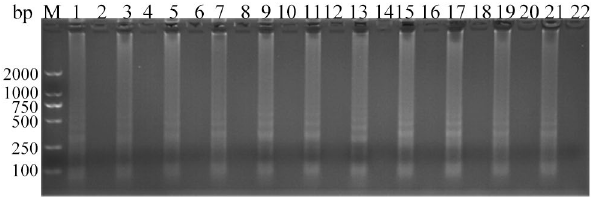
Figure 2. Analysis of ALV-J CPA at different concentration of primers (Table 1) by agarose gel electrophoresis. Lane M, DNA marker; 1, 3, 5, 7, 9, 11, 13, 15, 17, 19, 21, were primers groups 1–11 (Table 1) respectively; 2, 4, 6, 8, 10, 12, 14, 16, 18, 20 and 22 were negative controls for the corresponding primers groups. The full-length gel is presented in Supplementary Figure